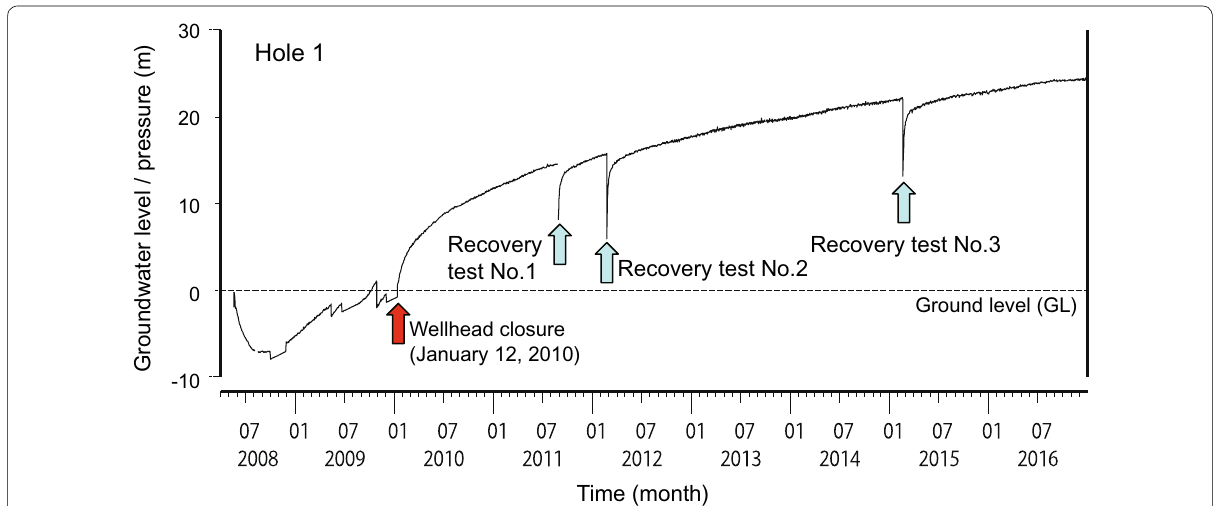
Fig. 2 Daily groundwater-level/pressure data from Hole 1. The red arrow shows when the wellhead was closed to observe groundwater pressure. Blue arrows denote three occasions on which the wellhead was temporarily opened and a recovery test was performed after